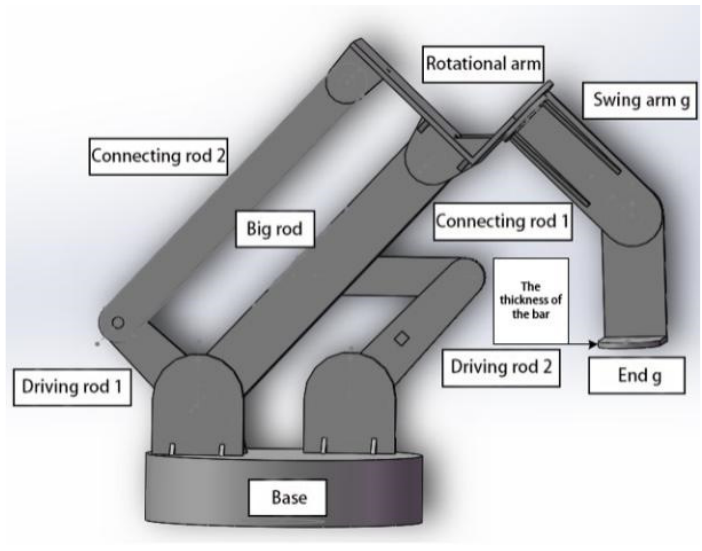
Figure 10. Series-parallel controllable mechanism welding robot component names. Table 3. Center composite design experimental data design table of bar thickness.